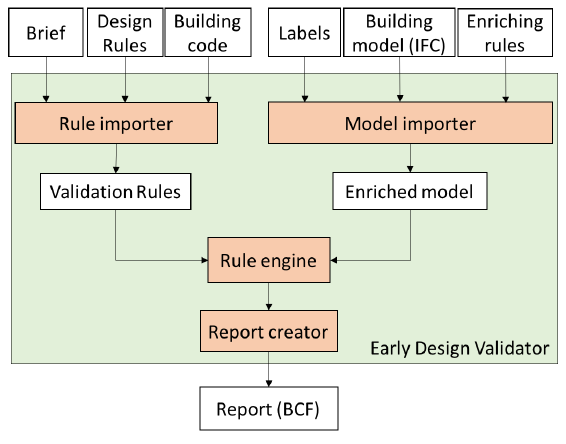
Figure 5. EDV internal